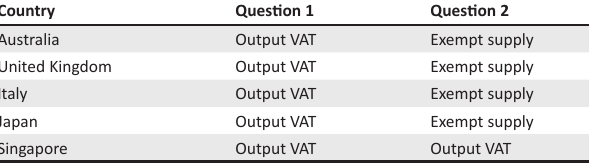
TABLE 1: Summary of different output tax consequences by country